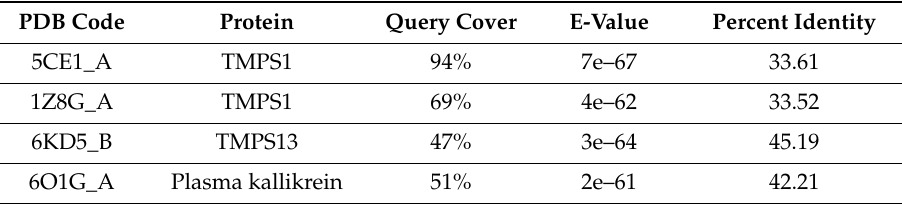
Table 1. Initial screening for possible templates using BLAST and SWISS-MODEL analyses against the PDB resolved structures .